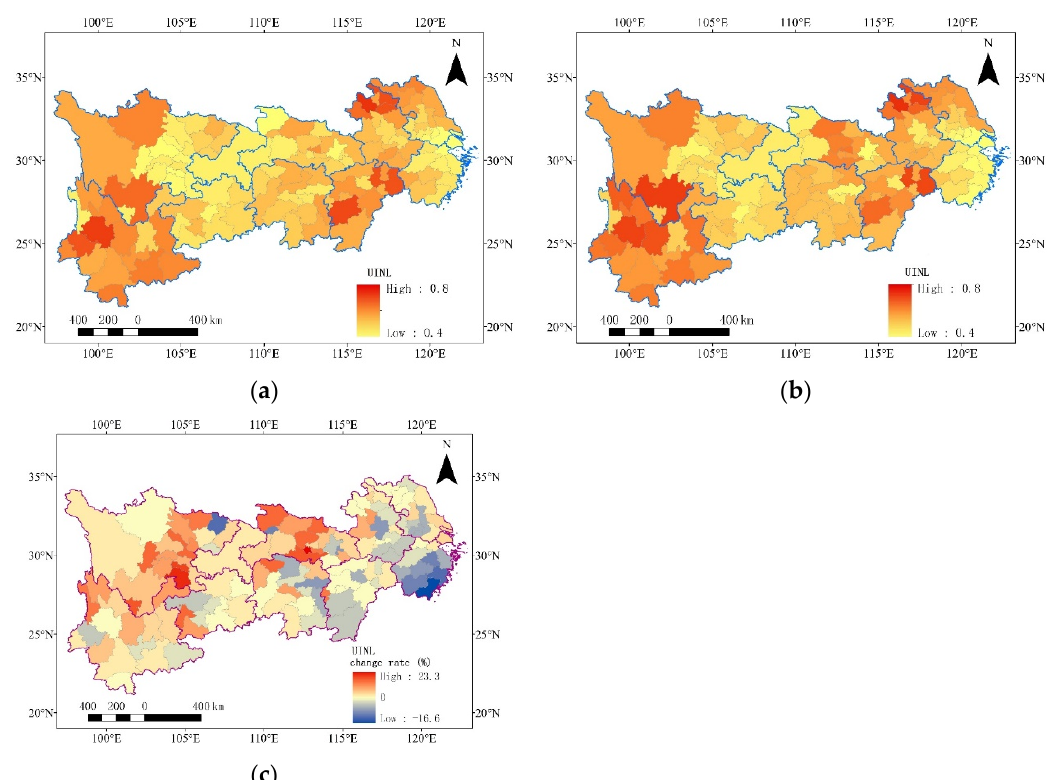
Land 2023 , 12 , 321 Figure 13. The UINL for the cities in the YREB: ( a ) 2012; ( b ) 2019; ( c ) the change rate.